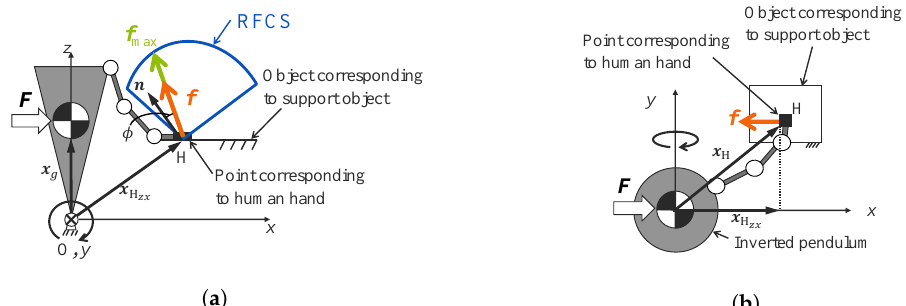
Figure 6. Model of balance recovery adapted from [8]. ( a ) View from − y axis; and, ( b ) view from + z